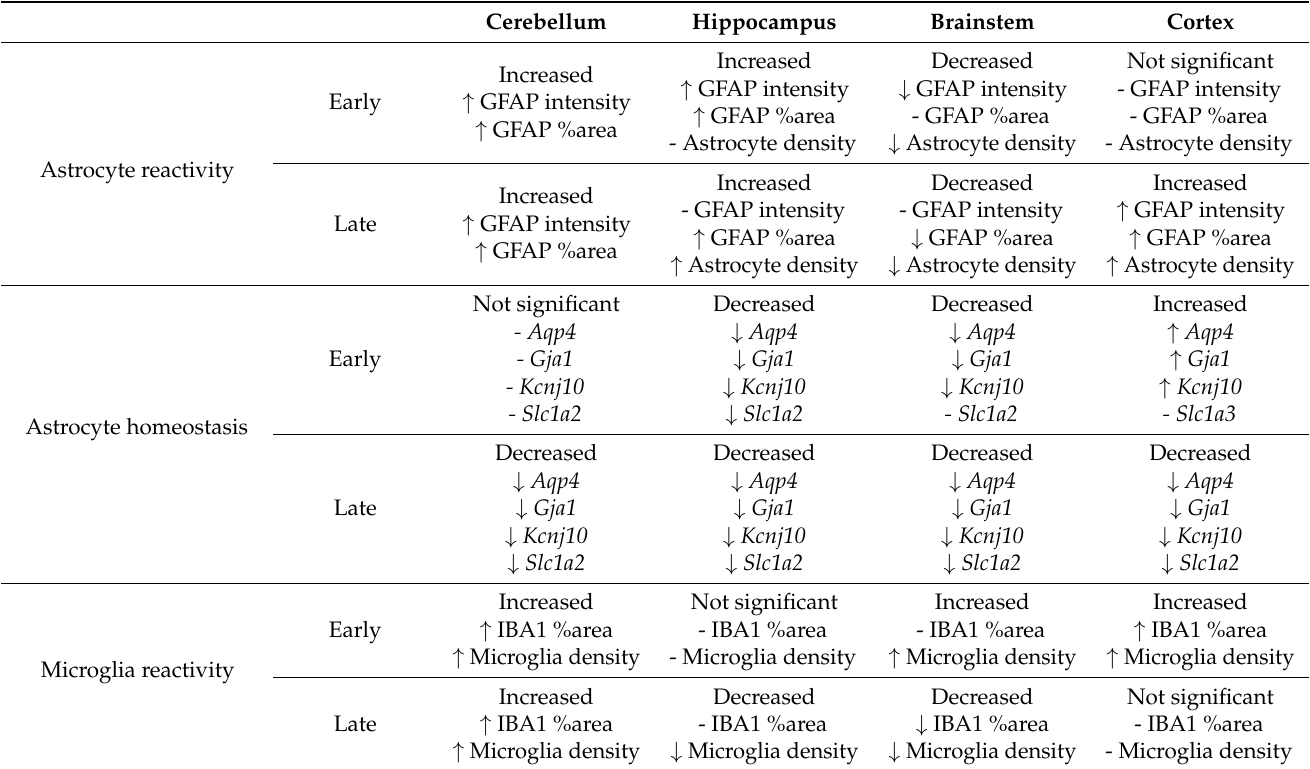
Table 1. Summary of glial changes in SCA1 across brain regions and disease